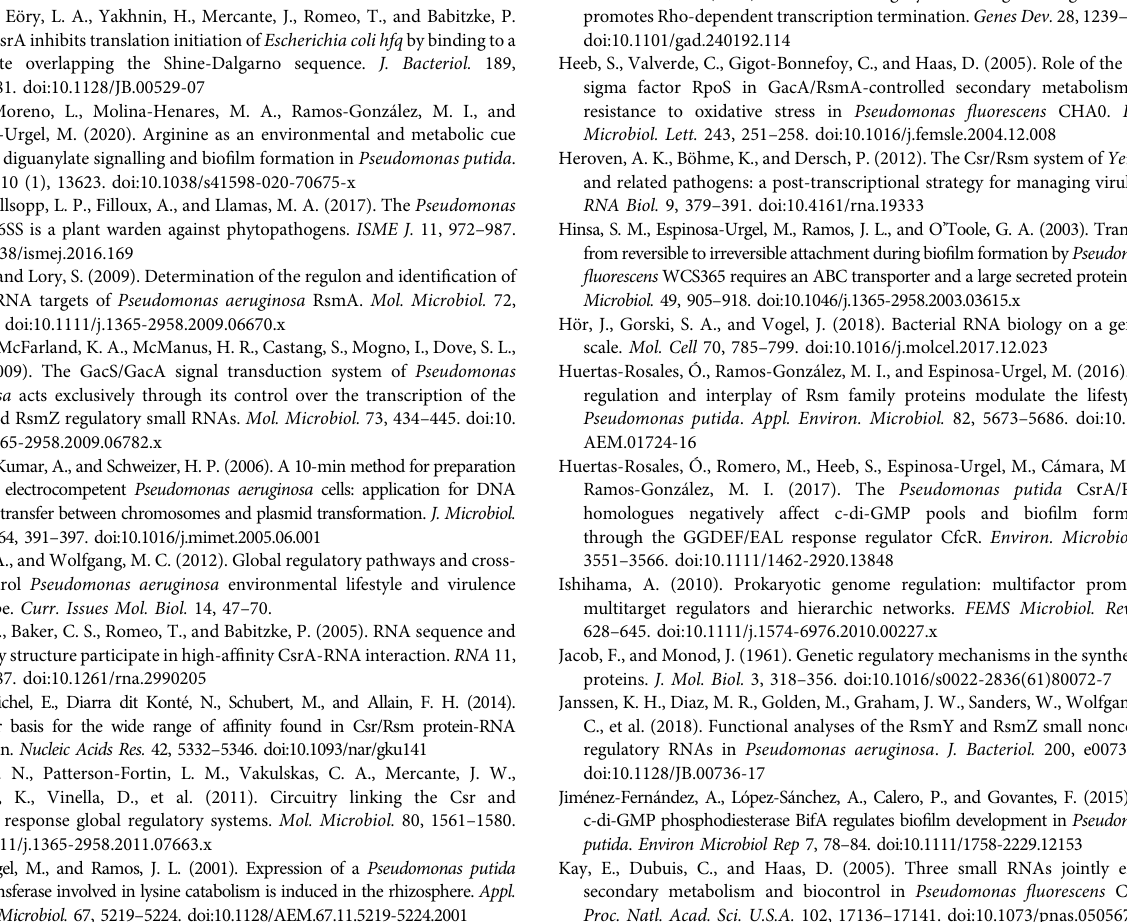
Figueroa-Bossi, N., Schwartz, A., Guillemardet, B., D ’ Heygère, F., Bossi, L., and Boudvillain, M. (2014). RNA remodeling by bacterial global regulator